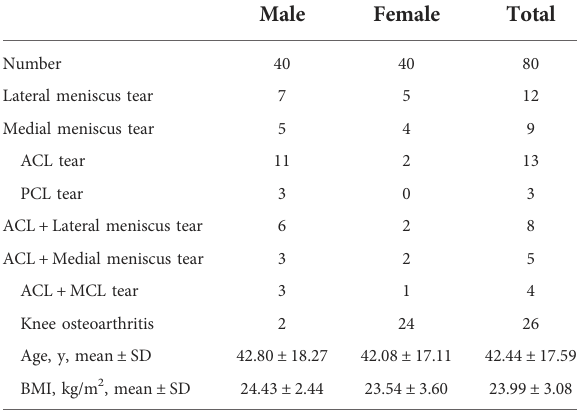
TABLE 1 Demographic data of